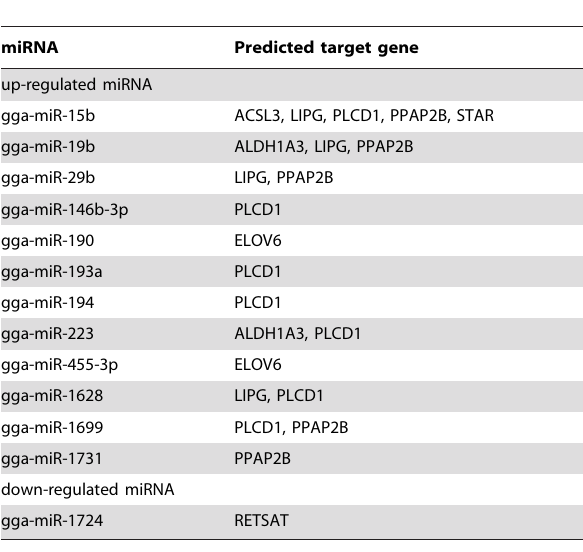
Table 10. Lipid metabolism-related genes predicted to be targeted by chGH-regulated